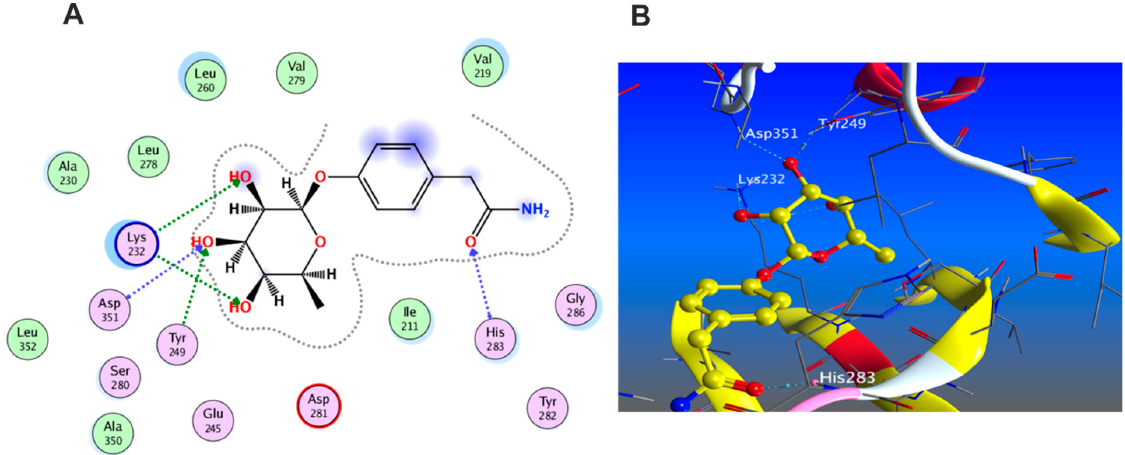
Figure 14. Docking results of compound 18 in the active pocket site of (TGF- β ) (6B8Y): ( A ) 2D interactions of compound 18 ( B ) 3D Docking pose of compound 18